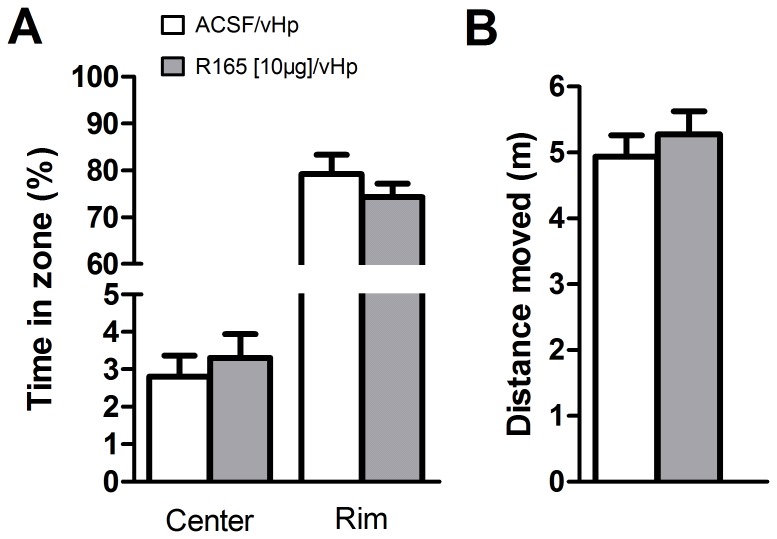
Effects of nectin-1 inhibition in the ventral hippocampus on anxiety-like behavior (A) and locomotor activity (B).Inhibition of nectin-1 by infusion of R165 into the ventral hippocampus did not affect time spent in the center, the rim area of the open field as measured 7 d later (A). In addition, locomotor activity in the open field was also not affected by R165 infusion 7 d before (B). Error bars represent standard error of the mean (n = 14 for ACSF-treated animals, n = 19 for R165-treated animals).